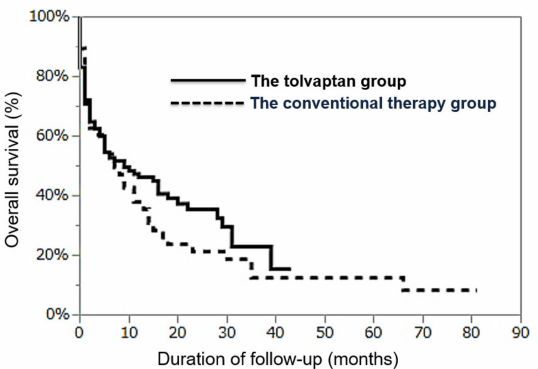
Figure 3. Comparison of cumulative survival rates between the conventional therapy group and the tolvaptan group.